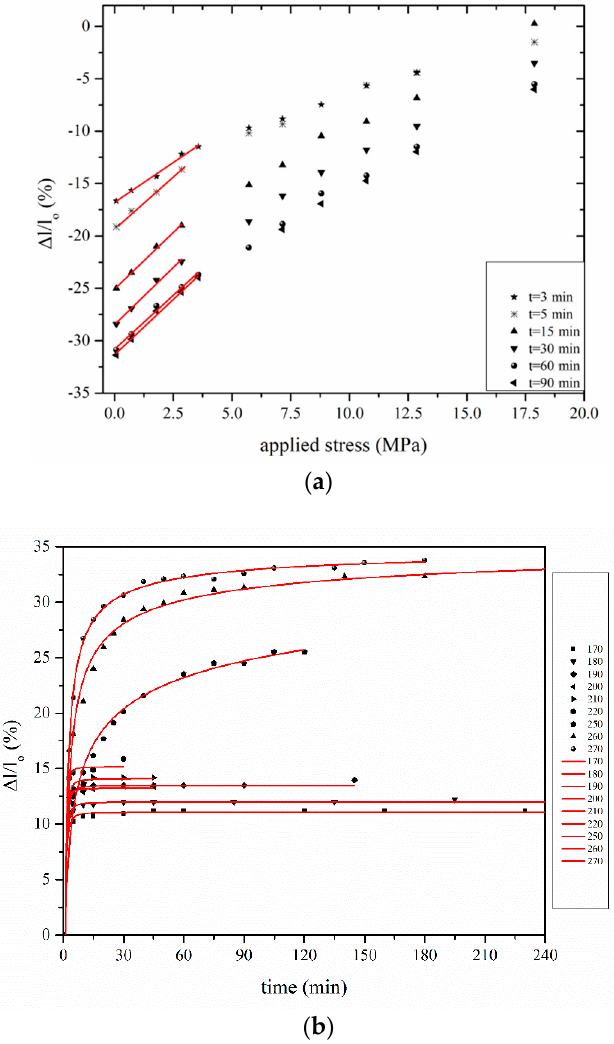
Figure 4. ( a ) Isochronous change of length during isothermal stabilization. ( b ) Entropic shrinkage versus treatment time for YTD PAN fiber at different temperature.